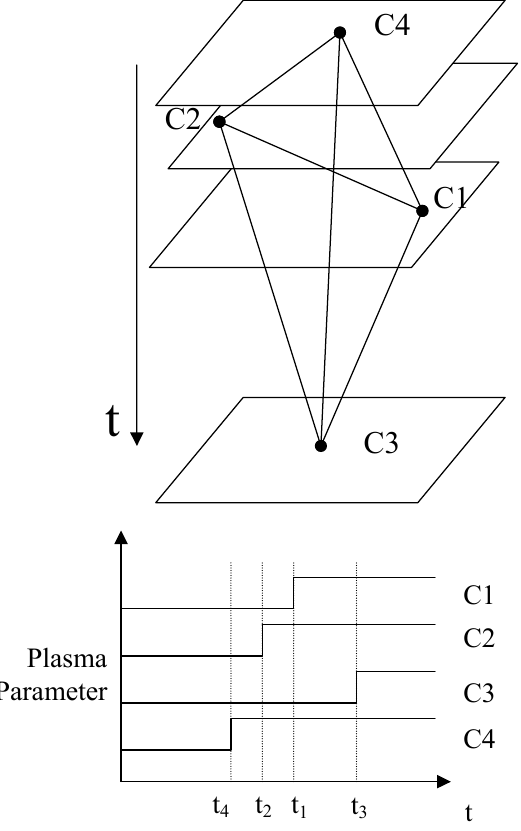
Fig. 1. A boundary between two distinct plasma regions passes over the Cluster quartet, marked by C1 to C4, and can be observed to cross spacecraft α at time t α . The plasma boundary is marked by a plane moving in the negative GSM–Z direction with time t . As the boundary passes each spacecraft for the different plasma pop- ulations a change is seen in the parameter time-series, shown here for all four spacecraft. The boundary is assumed to be planar on the scale of the